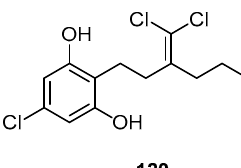
Figure 29. Chemical structure of poipuol ( 120 ).